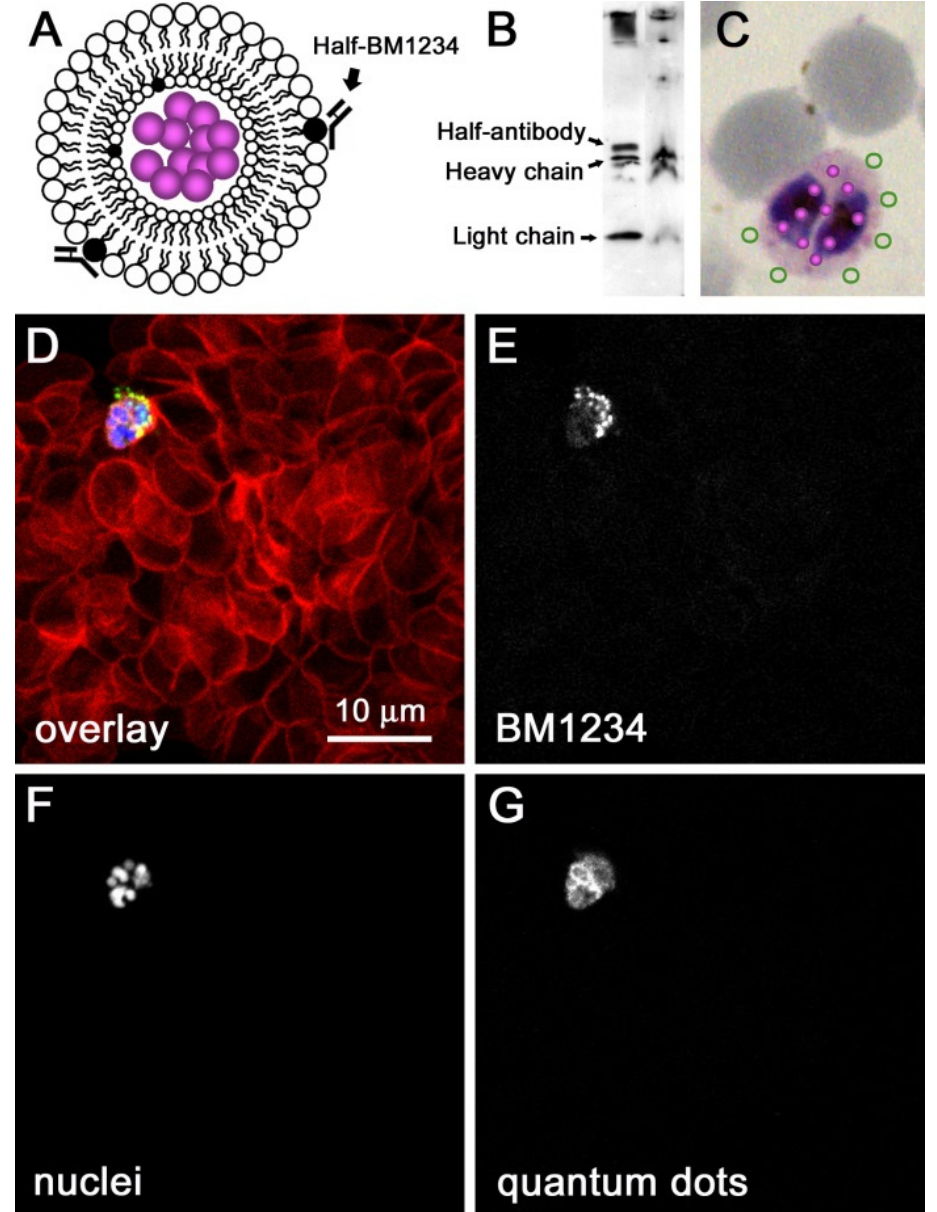
Figure 4. Confocal fluorescence microscopy analysis of the delivery of immunoliposome cargo to pRBCs. ( A ) Cartoon showing a quantum dot-containing liposome functionalized with half-antibodies. ( B ) Western blot analysis of the conjugation to liposomes (right lane) of the pRBC-targeting BM1234 antibody. Immunoliposomes were purified by ultracentrifugation prior to electrophoresis. ( C ) Graphical scheme of the expected performance of nanovectors when added to a P. falciparum culture containing both infected and noninfected cells. ( D ) Confocal fluorescence microscopy section of a suspension of RBCs containing ca. 5% pRBCs that had been treated, for 90 min and prior to fixation, with a preparation of immunoliposomes assembled as depicted in ( A ). The selected field contained a single pRBC among tens of noninfected cells, showing the fluorescence of RBC plasma membranes (red), antibody detection (green), quantum dots (white), and nuclei (blue). For easier visualization of the colocalization of quantum dots and antibodies only in pRBCs, the fluorescence signals for ( E ) antibodies, ( F ) nuclei, and ( G ) quantum dots are shown separately in white. Reproduced with permission from [87], Elsevier B. V.,